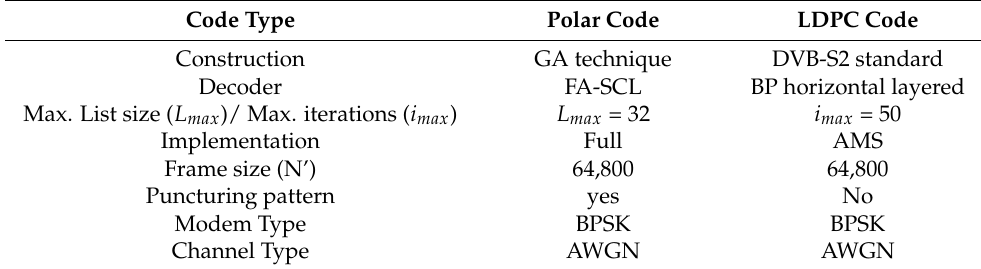
Table 2. Simulation parameters for polar and LDPC